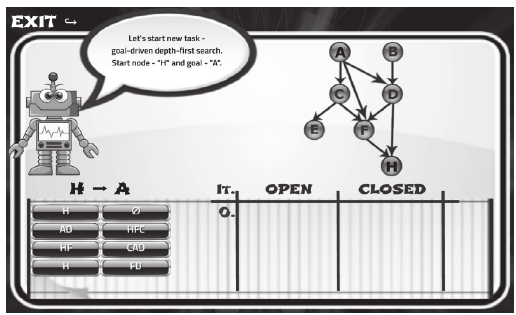
Fig. 3. Game interface and learning/practice activities.